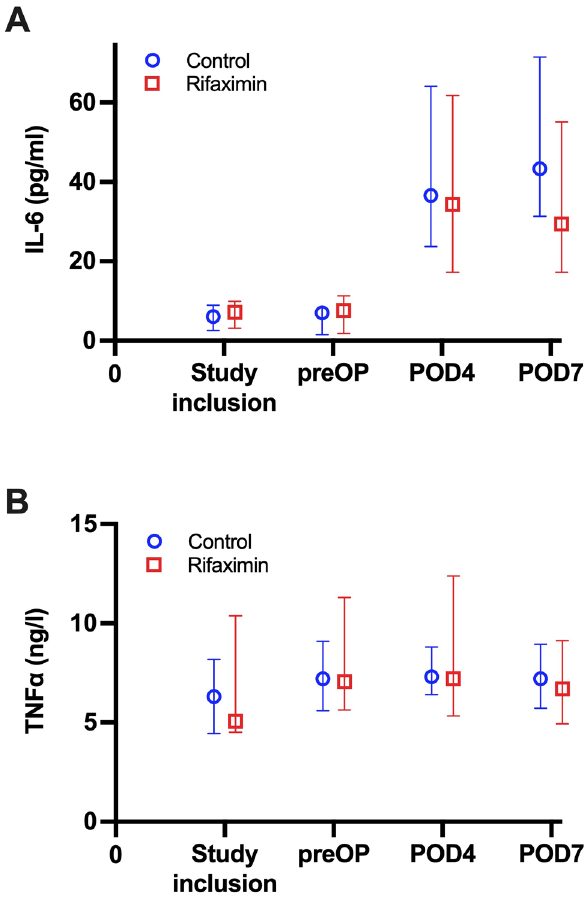
Figure 5. Course of cytokines with respect to trial group. ( A ) IL-6. The course of serum IL-6 levels is presented as median and interquartile range. There was no significant difference in IL-6 levels between the Rifaximin and control group at any of the time points (study inclusion: p = 0.825; preOP: p = 0.798; POD 4: p = 0.953; POD 7: p = 0.597). ( B ) TNFα. The course of TNFα is presented as median and interquartile range. Also, no time point showed statistically significant difference between the Rifaximin and control group (study inclusion: p = 0.746; preOP: p = 0.635; POD 4: p = 0.468; POD 7: p = 0.144). IL, Interleukin; POD, postoperative day; preOP, prior to surgery. TNF, tumor necrosis